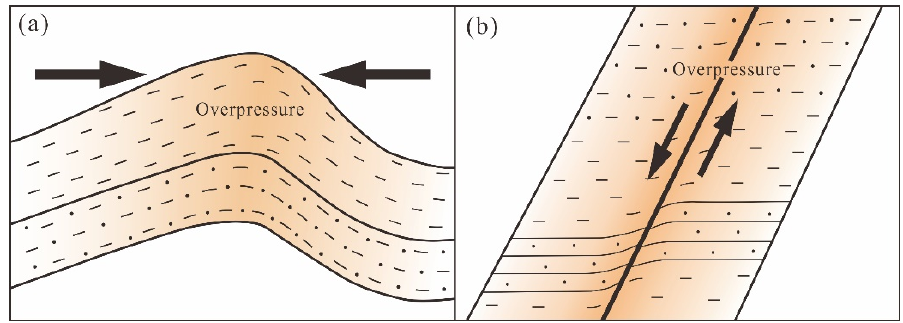
Figure 6. Schematic diagram of tectonic-related overpressure development: ( a ) compression, ( b ) shear.